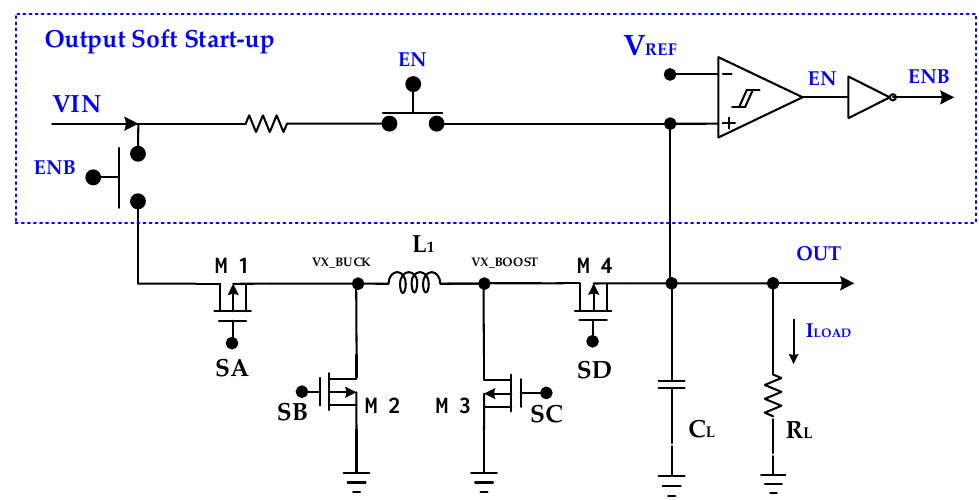
Figure 6. The proposed output soft start-up circuit.